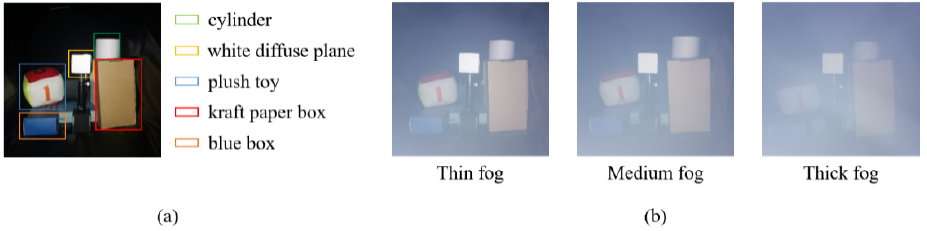
Figure 8. Experimental scene. ( a ) Target objects. ( b ) Scenes under different thicknesses of fog. The numbers of scattering particles per cubic decimeter are 753,640, 935,340, and 1,204,890 from left to right.